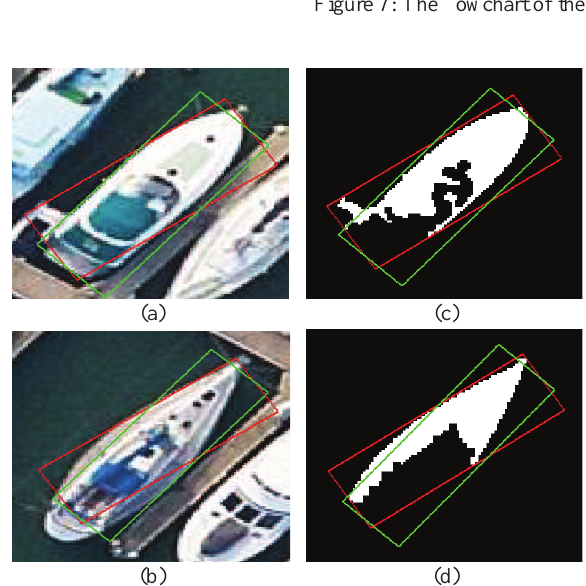
Figure 6: Two examples of MBR adjustment: (a)-(b): original remote sensing images; (c)-(d): the corresponding connected mask region of (a) and (b), respectively. The red rectangles stand for the original MBRs obtained from the segmentation mask image while the adjusted MBRs are marked in green